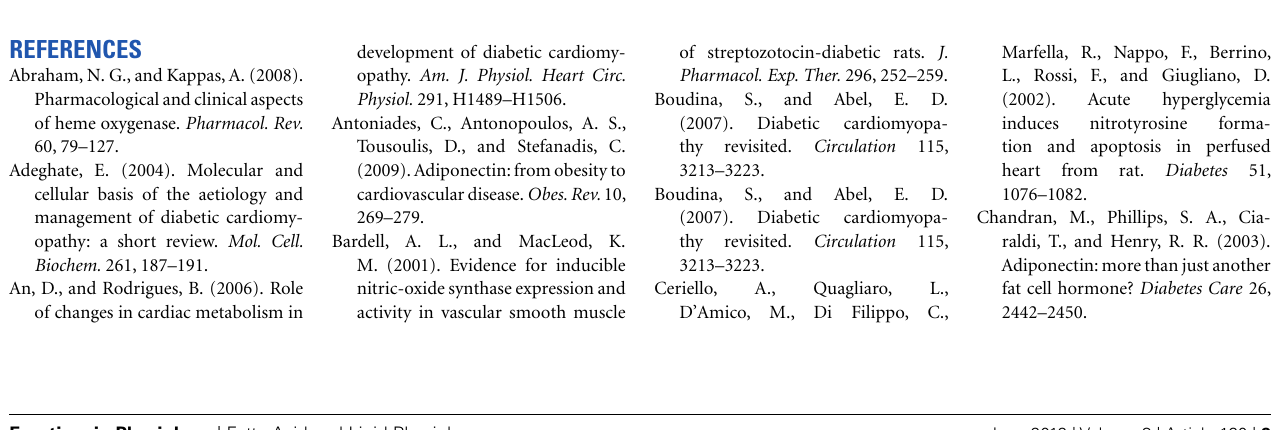
of GLUT4 via PI-3-kinase, the same signaling cascade activated by insulin ( Figure 7 ). Human studies demonstrate that plasma adiponectin and HO-1 expression regulate insulin sensitivity and insulin receptor phosphorylation (Yamauchi et al., 2001; Stefan et al., 2004) contributing to increased insulin sensitivity. As a consequence, enhanced glucose utilization in CoPP-treated dia- repletion which in turn has the potential to enhance cellular malonyl-CoA. Together with improved myocardial perfusion and increased malonyl-CoA, reduced β -oxidation of FFA in myocar- dial cells could attenuate lipid peroxidation, oxidative stress, and improve myocytes